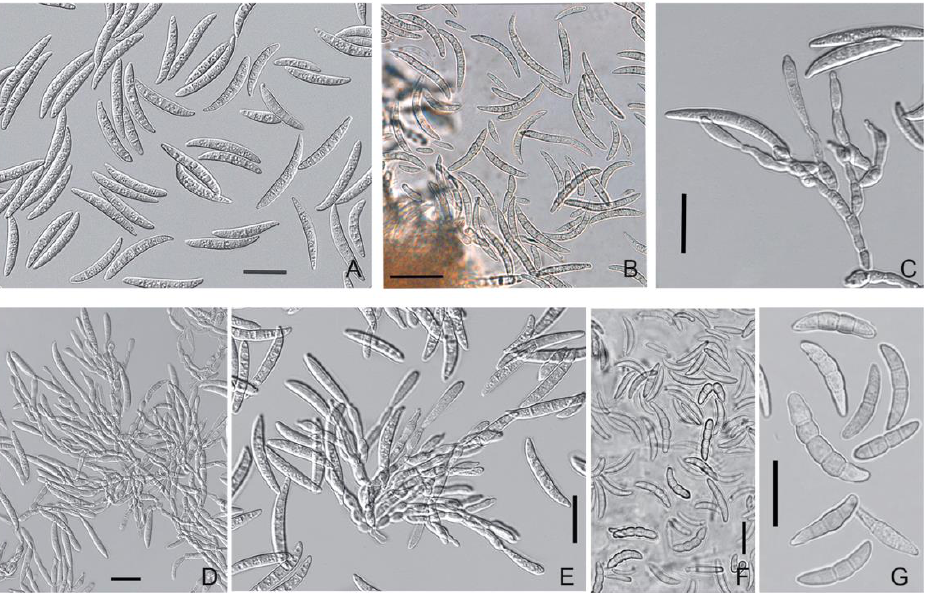
Figure 6. Microdochium sp. strain MFG 58962: ( A , B ) conidia; ( C – E ) conidiophores with conidiogenous cells; and ( F , G ) thick walled conidial cells. Media: ( A – E ) PSA; ( F , G ) oatmeal agar. Scale bars: ( A – G ) 20 μm.